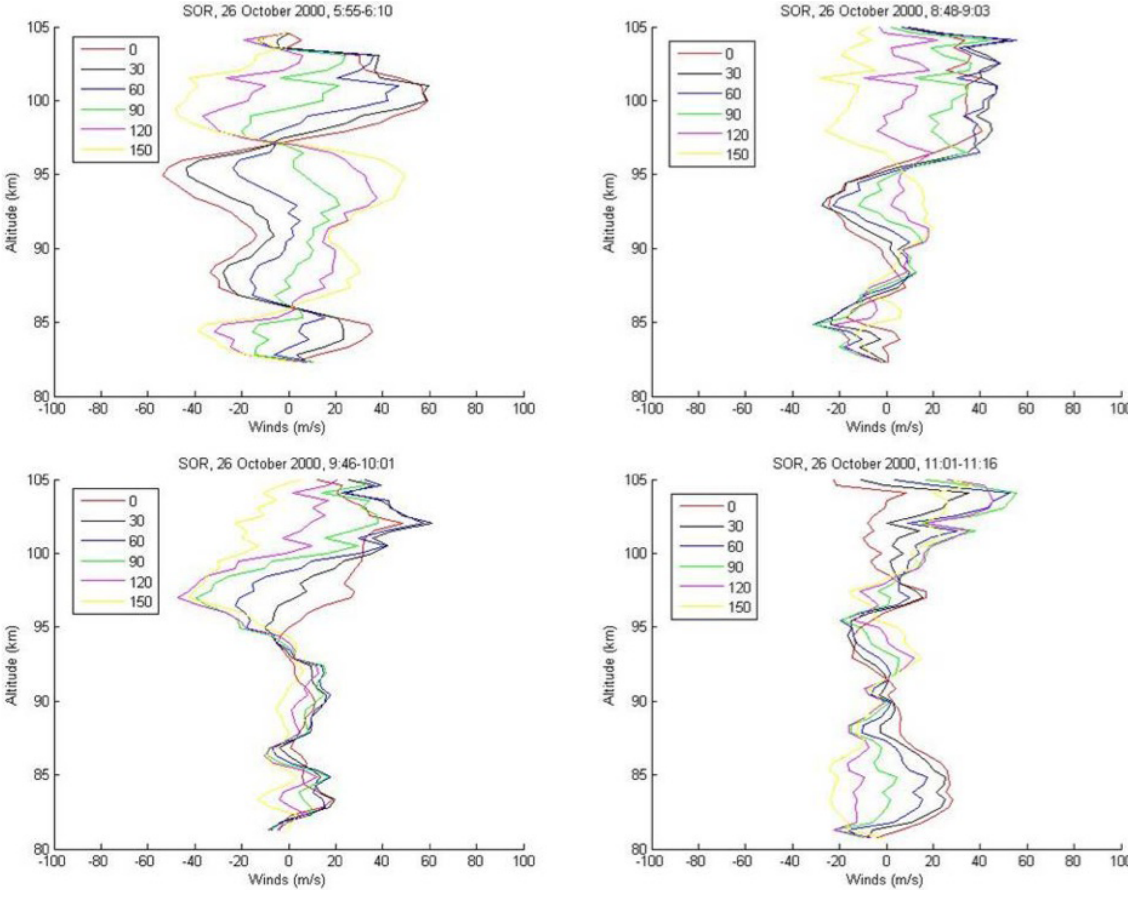
Fig. 8. Wind profiles showing shears and and the inflection point for varying vertical orientations at different stages of the observing period for 26 October 2000. The legend refers to the degrees of the direction for the corresponding